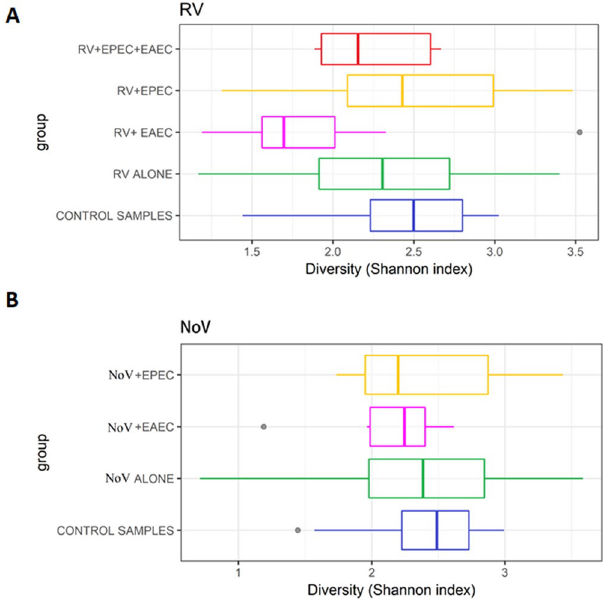
Figure 3. Shannon diversity index of microbiota among healthy controls and infected AGE cohorts. ( A ) Analysis of Shannon diversity index in control samples, RV-alone, RV + EAEC, RV + EPEC, and RV + EPEC + EAEC. ( B ) Analysis of Shannon diversity index in control samples, NV-alone, NV + EAEC, and NV +